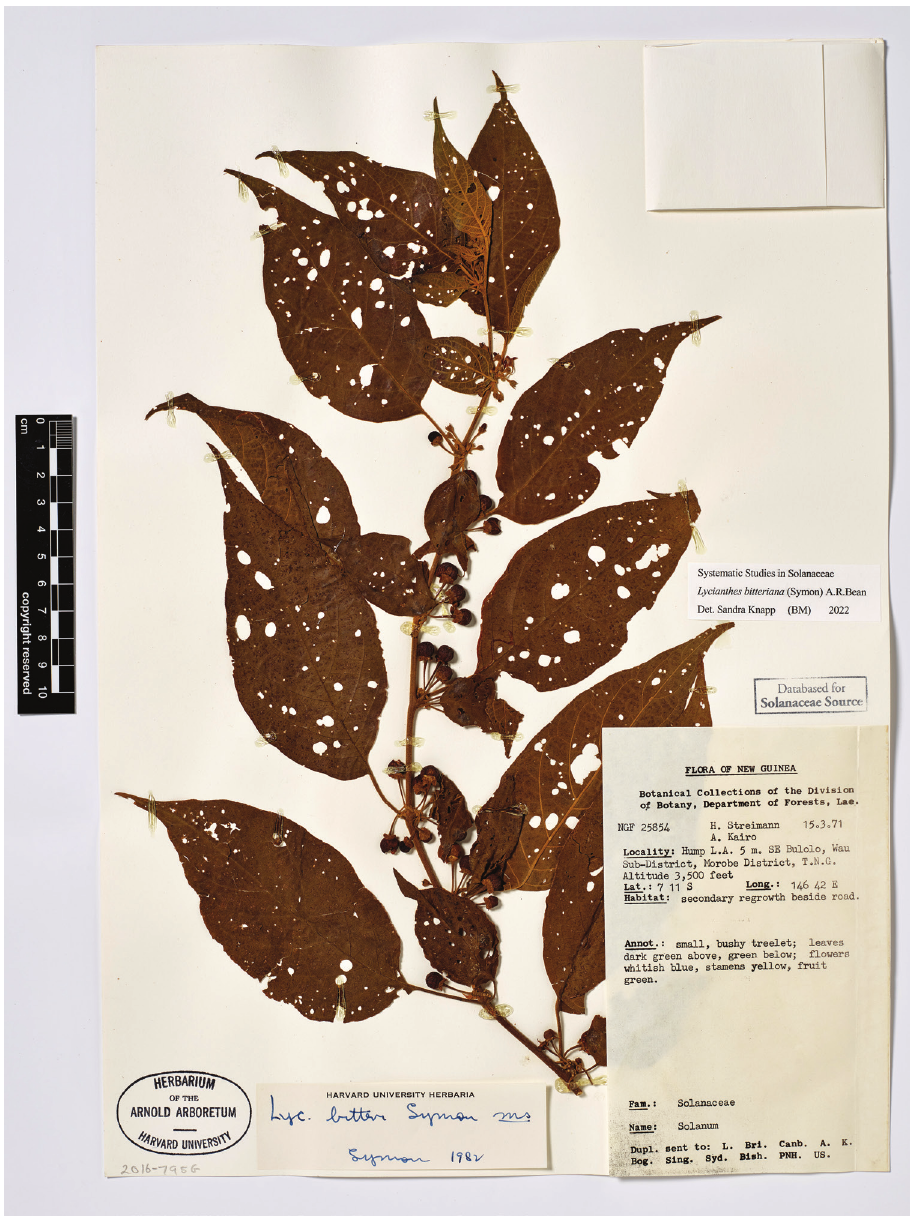
Figure 14. Lycianthes bitteriana herbarium specimen. Papua New Guinea. Morobe: Streimann & Kairo NGF-25854 (A). Courtesy of the Herbarium of the Arnold Arboretum of Harvard University, reproduced with